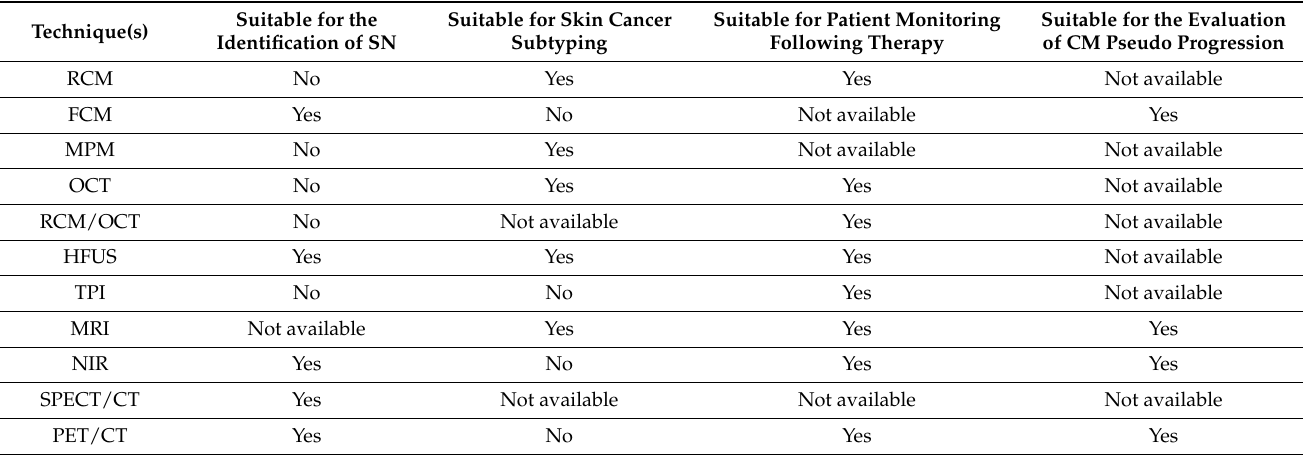
Table 2. Prospective applications of anatomical and molecular imaging techniques in dermato-